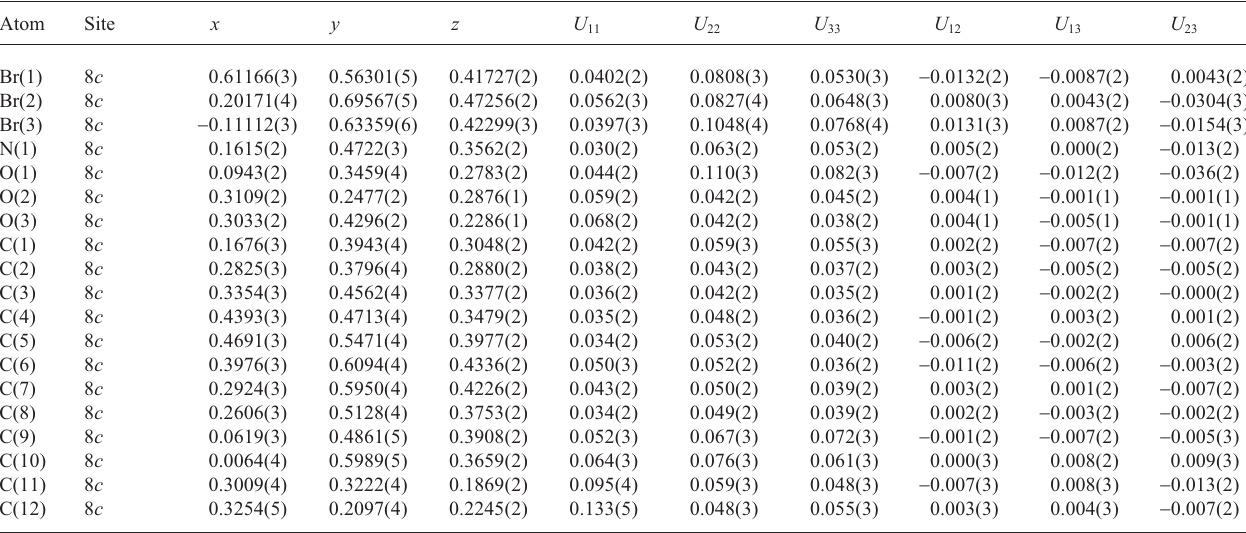
Table 3. Atomic coordinates and displacement parameters (in Å 2 )